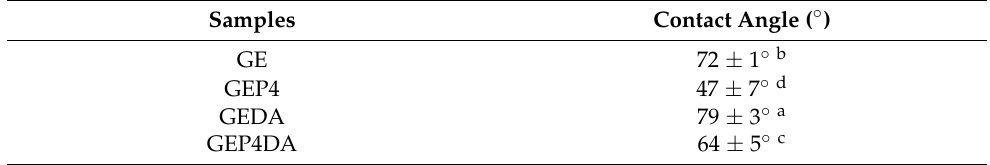
Table 3. Contact angle ( ◦ ) of the